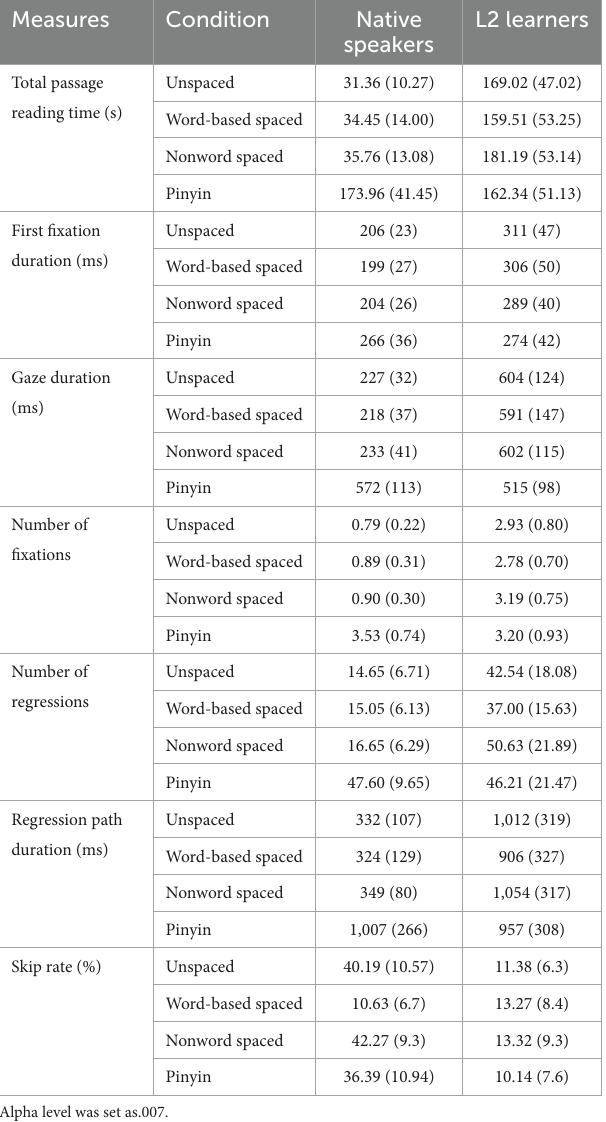
TABLE 4 Descriptive statistics for eye movement measures across the four presentation conditions (SD in